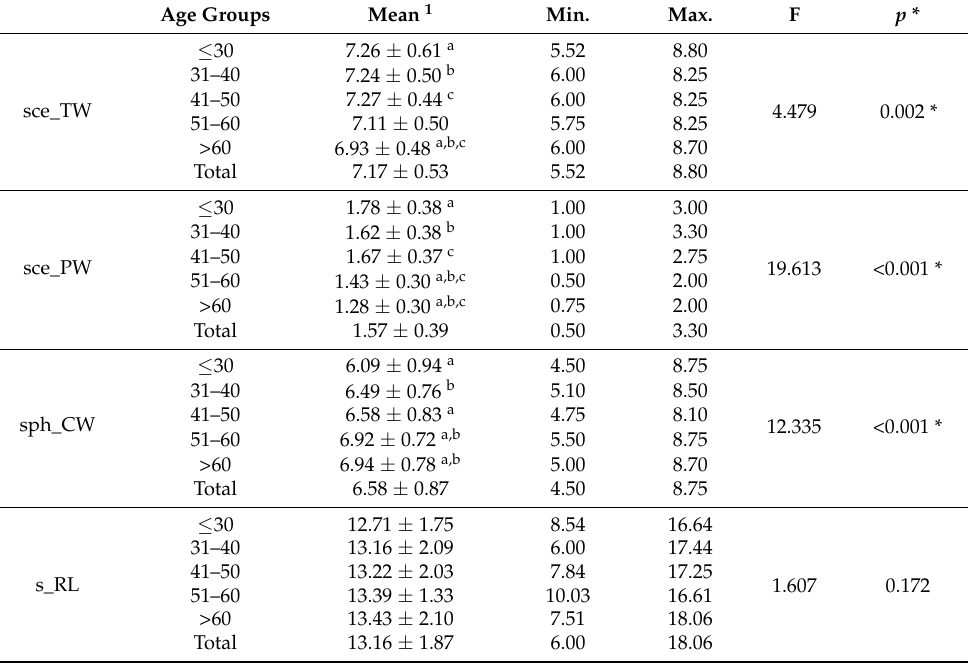
Table 1. Differences in sagittal linear measurements and ratios between age